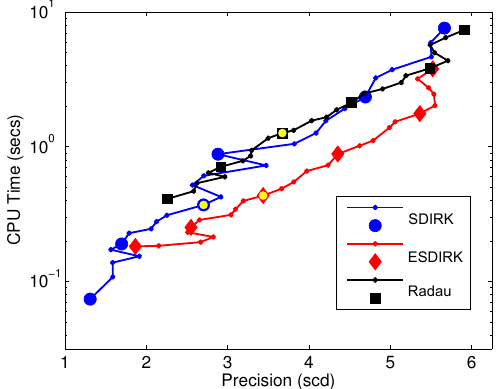
Fig. 7: GABA R work-precision diagram with A solver run time vs. scd for each IRK method. Integer exponential tolerances, i.e. 10 − 4 , 10 − 5 , ..., are presented with enlarged symbols. The symbol for rtol = 10 − 6 is distinguished by the yellow